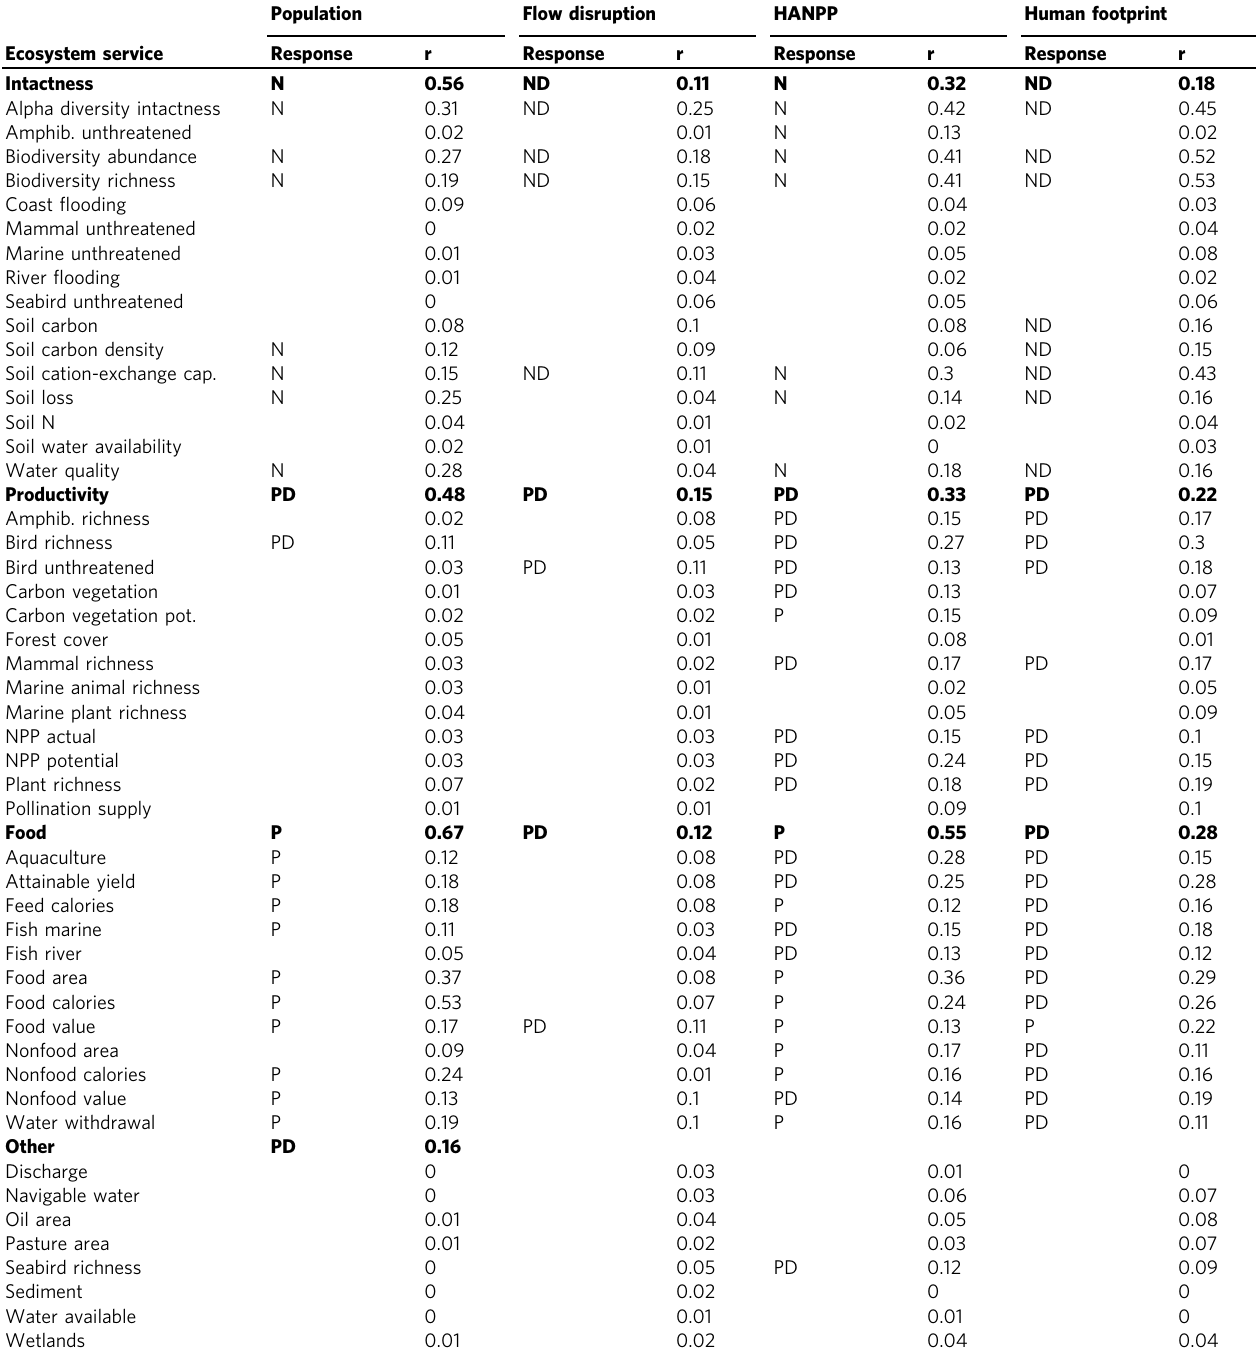
Table 2 Responses to modi fi cation shown by individual ecosystem service indicators and unsupervised